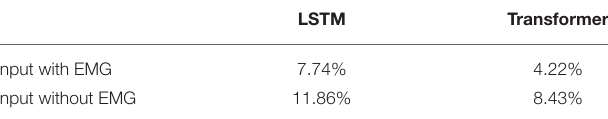
TABLE 3 | Word error rate comparison.